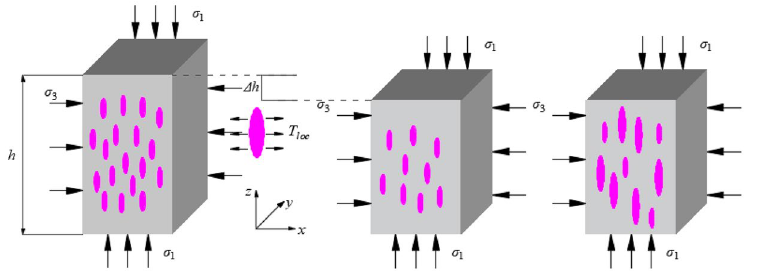
Figure 2. Two crack propagation modes 18 .